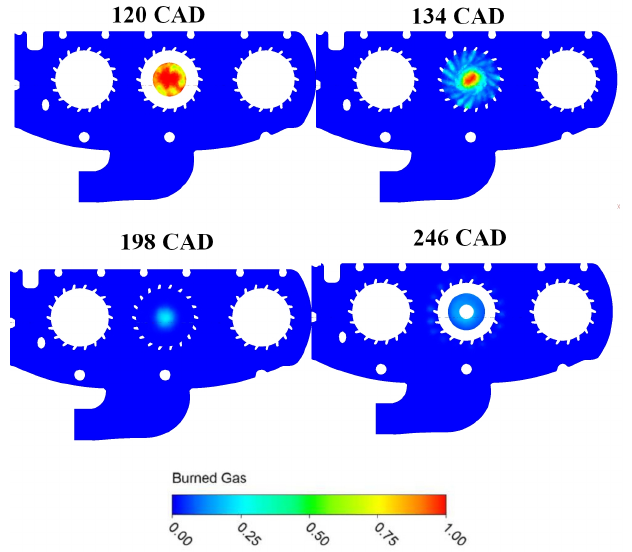
Figure 11. Contour plot of the Burned Gas mass fraction at several instants on the plane